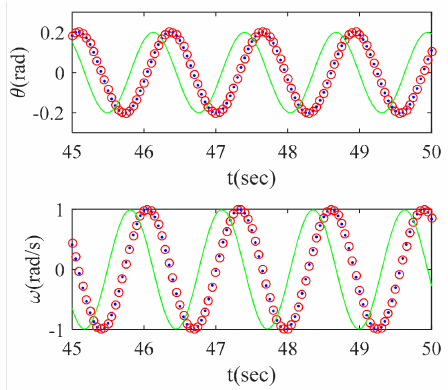
Figure 11. The results under reduced attitude and triangle function